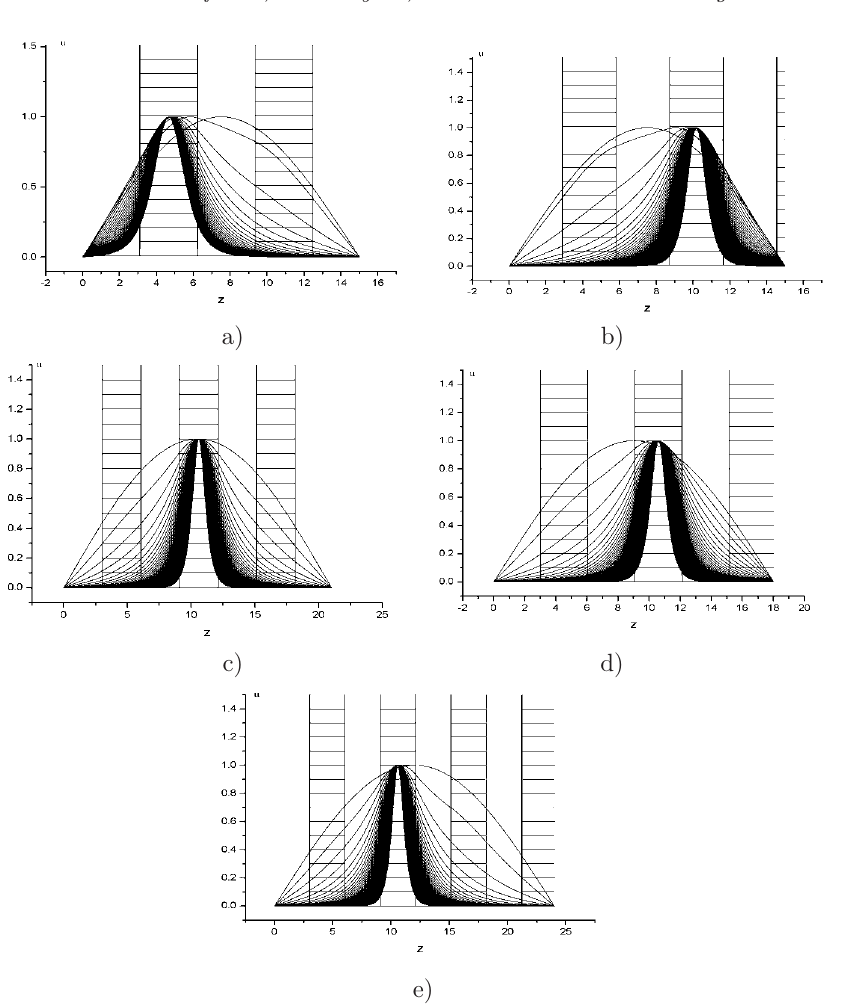
Figure 3. Transformation of EF profile in dependence on | α 2 | , which is changing from 0 to 40, for various ratio of a nonlinear layer centre position and the position of centre of initial spatial distribution of EF at α 2 = 0 . 0 for L = 15 ,d 1 = d 2 = 3 . 0 (a) L = 15 ,d 1 = d 2 = 2 . 9 (b), L = 21 ,d 1 = d 2 = 3 . 0 (c), L = 18 ,d 1 = d 2 = 3 . 0 (d), L = 24 ,d 1 = d 2 = 3 . 0 (e) and α 1 = 0 , Ω = 1 / ( 4 π ) , ε 1 = ε 2 = 1 . 0 (homogeneous medium). A width of EF decreases with increasing of | α 2 | . Areas with horizontal lines correspond to nonlinear layers of a photonic